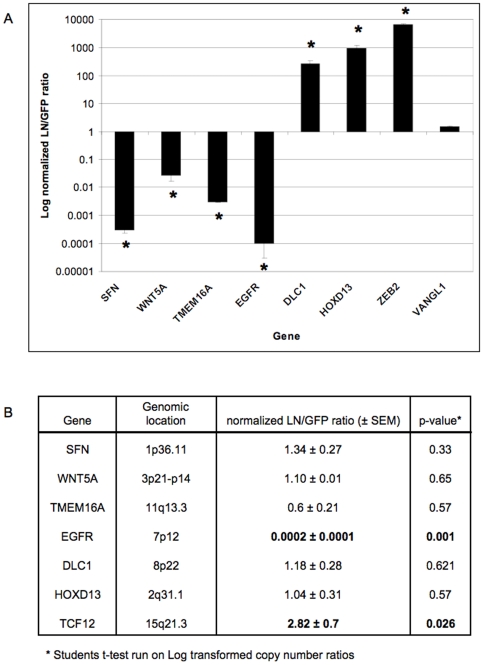
Expression and copy number analyses.A: Quantitative real time RT-PCR expression data for each of these genes, including EGFR. Scale of the y-axis is log10 of the fold change. B: Determination of copy number by quantitative real time PCR (qRT-PCR). Primers spanning an exon of the gene of interest were designed using ExonPrimer software, and qRT-PCR performed using 15 ng genomic DNA from 3 biological replicates each of LN and GFP DNA as template. Shown is the LN/GFP ratio, ± standard error of the mean (SEM). Data were normalized to β-globin as a reference gene. A p-value <0.05 indicates that mean normalized LN copy numbers in LN triplicates were significantly different from those in GFP.